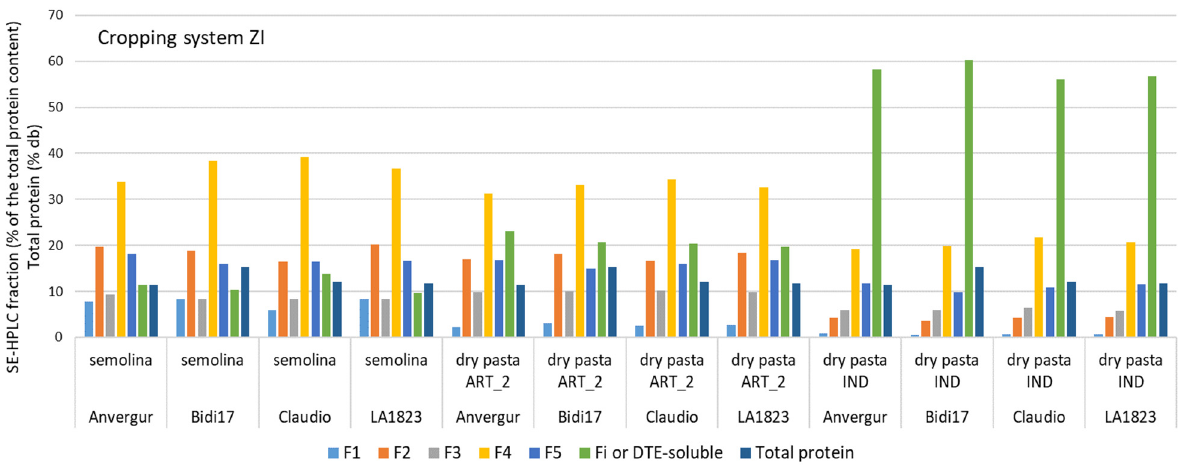
Figure 7. Comparison of the relative proportions of the different protein fractions between stone- milled grains (semolina) grown in 2017 under ZI cropping system and 2 different processes: “Artisanal 2” (ART_2) and “Industrial” (IND).